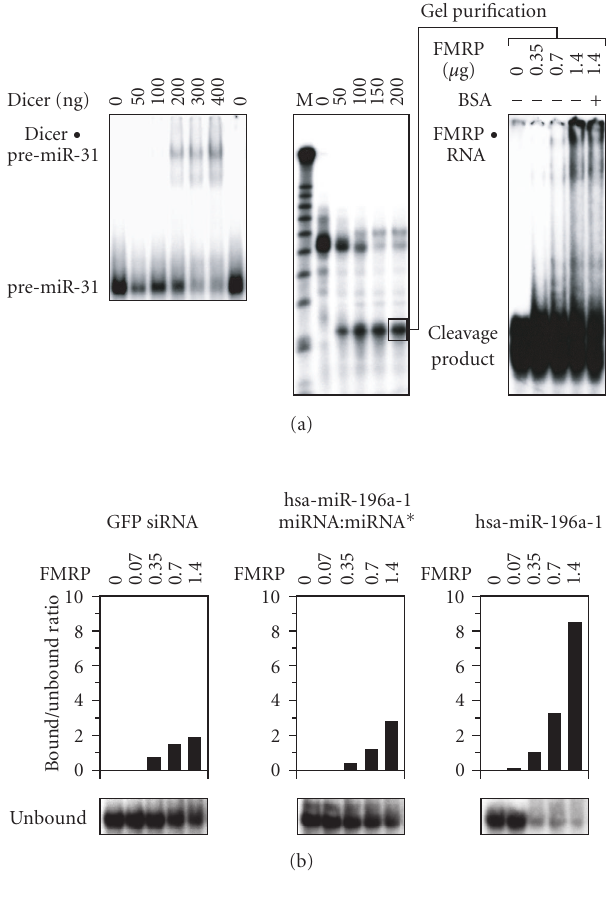
Figure 1: FMRP can act as an acceptor of miRNA derived from Dicer cleavage of pre-miRNA. (a) Recombinant FMRP interacts with Dicer RNA cleavage products. 32 P-labeled pre-miR-31 was incubated in the absence or presence of recombinant Dicer, without (left) or with (center) MgCl 2 . The samples were analyzed by nondenaturing (left) or denaturing (center) PAGE and autoradiography. RNA derived from Dicer cleavage was gel-purified and incubated with increasing amounts of recombinant FMRP (0 . 35–1 . 4 μ g), without or with BSA (20 μ g), prior to EMSA analysis (right). M indicates a 10-nt RNA size marker. (b) FMRP preferentially interacts with miRNAs. 32 P-labeled green fluorescent protein (GFP) siRNA (left), hsa-miR-196a-1 miRNA:miRNA ∗ duplex (center), or miRNA (right) was incubated in the absence or presence of increasing amounts of recombinant FMRP. The samples were analyzed by EMSA and autoradiography, and analyzed quantitatively by PhosphorImaging. Bound RNA was expressed as a bound to unbound